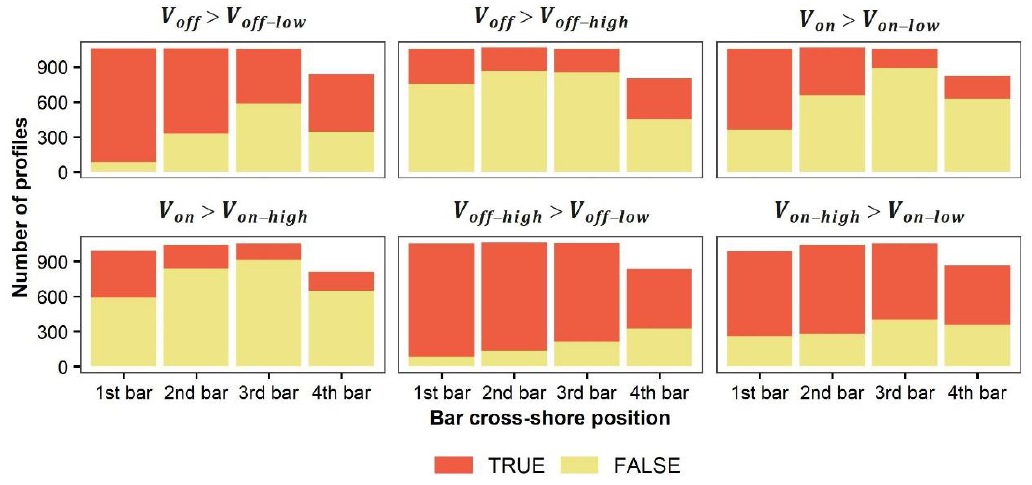
Figure 9. Comparison of bar cross-shore migration rates on different timescales. The orange in the figure indicates the number of cross-shore profiles where the average migration rates on the timescale on the left side of the greater-than sign exceeded the rates on the timescale on the right side; pale yellow indicates where the right side exceeded the left side.